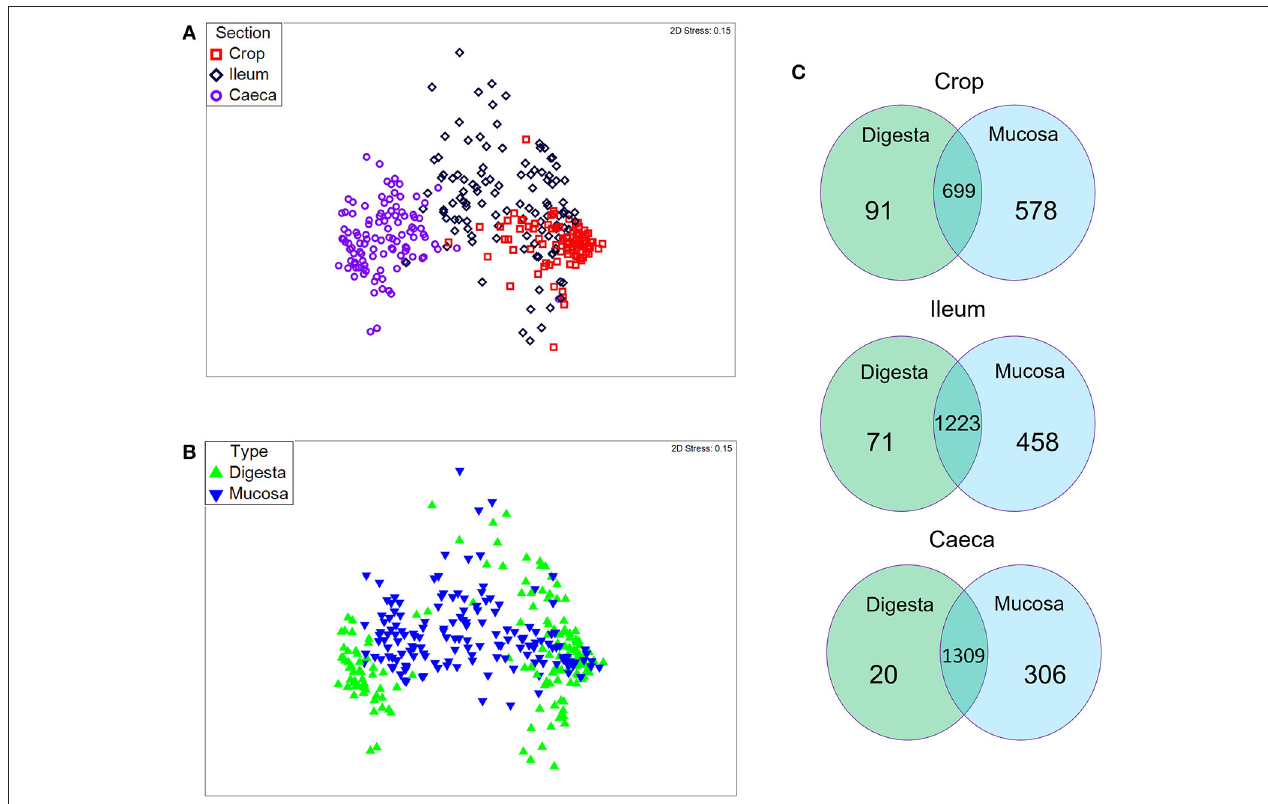
FIGURE 1 | Global bacterial community structure of 281 samples. Sequencing data was standardized prior to the use of Bray-Curtis similarity algorithm. Non-metric multi-dimensional scaling (nMDS) plot illustrates: (A) crop, ileum and caeca samples, and (B) digesta and mucosa samples. The symbols represent a unique sample comprising all OTUs and its abundance information. (C) Venn diagram of the OTUs common/unique to each type of sample in the crop, ileum, and caeca. Overlapping areas show the OTUs shared between digesta and mucosa